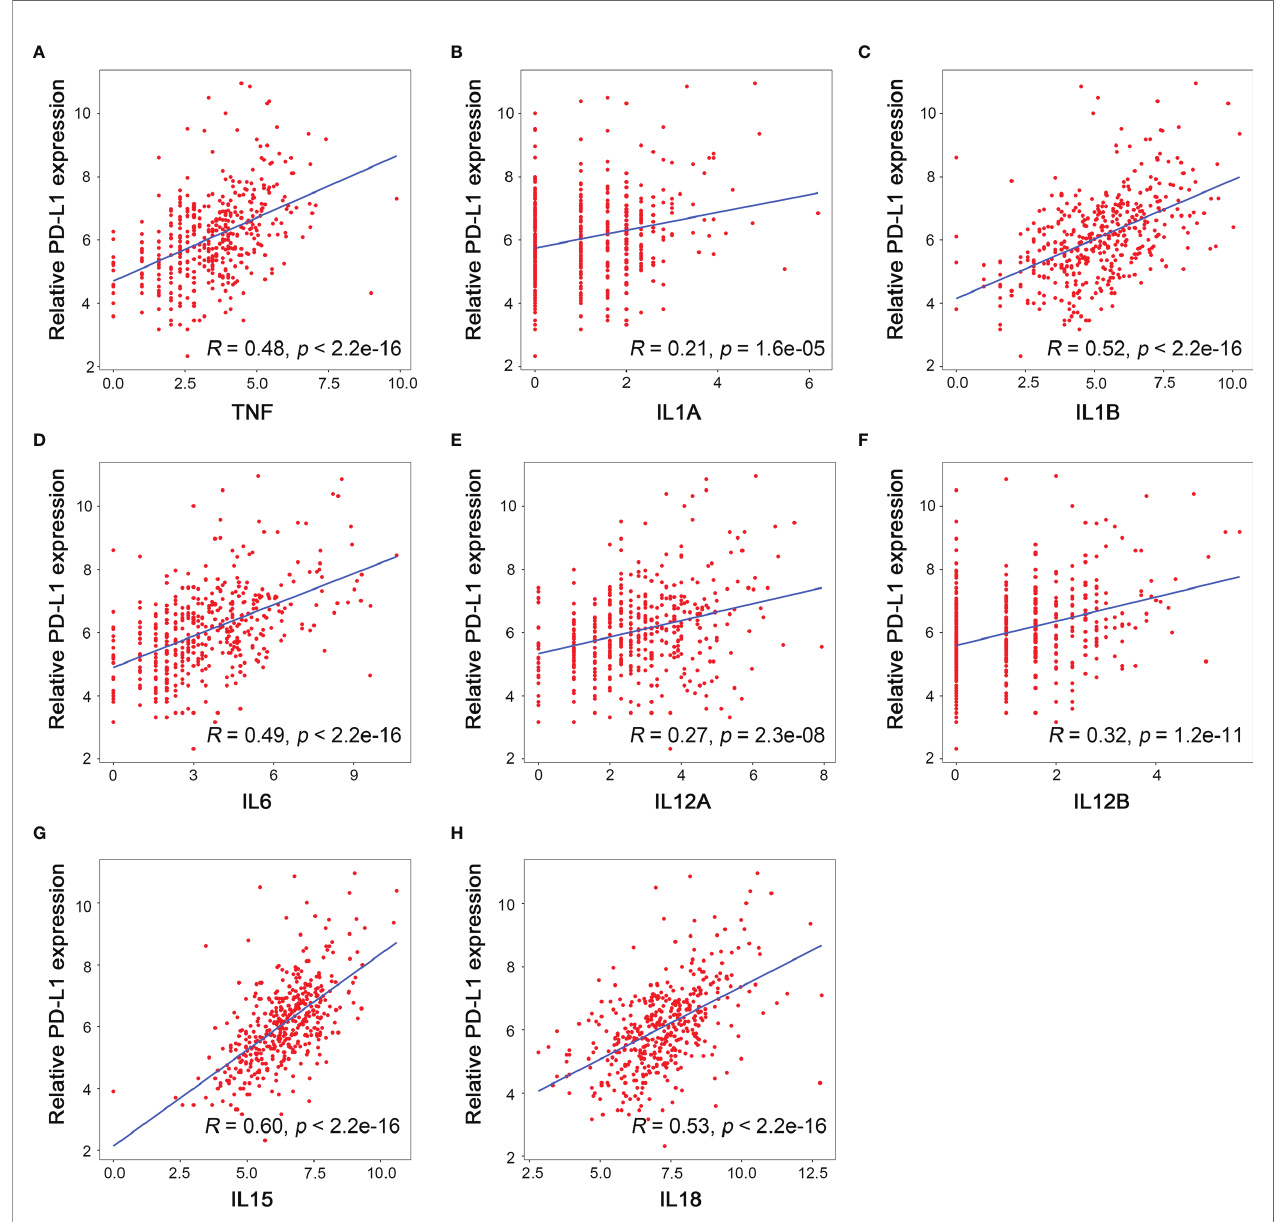
FIGURE 7 | Relationship between the mRNA level of M1 related cytokines and PD-L1 expression. (A) TNF, (B) IL1A, (C) IL1B, (D) IL6, (E) IL12A, (F) IL12B, (G) IL15, (H)